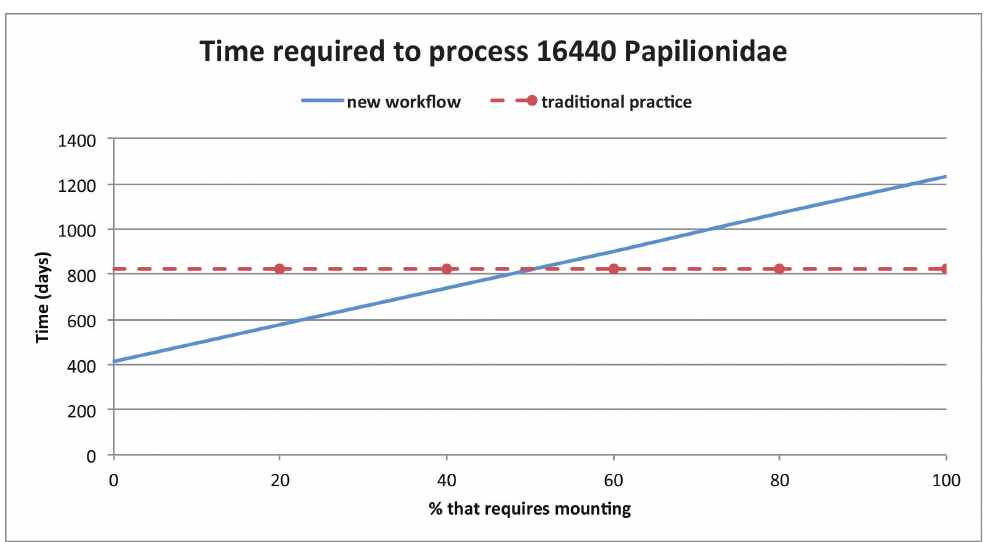
Proposed Proposed method - method -